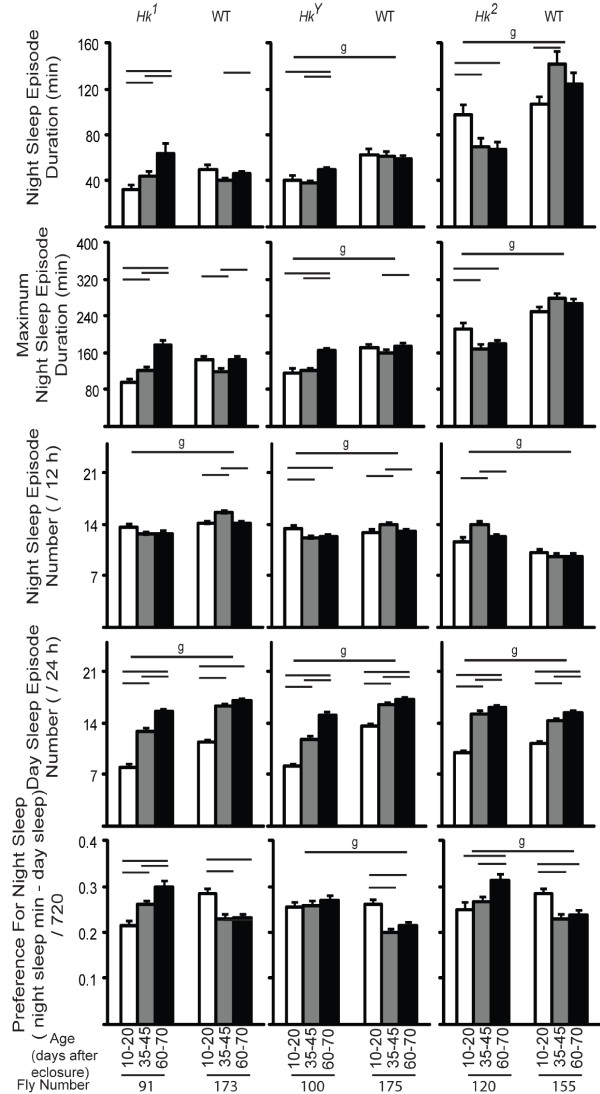
Sleep parameters during night and day in flies that lived at least 73 days. Values are mean + SEM (eleven 12-hour intervals averaged per each fly, and then averaged across all flies). Genotype (g) effects were tested across all ages (Kruskal-Wallis test, p < 0.05). Horizontal bars indicate significant age-related effects within each genotype (Friedman test followed by Wilcoxon signed-rank test, p < 0.05).